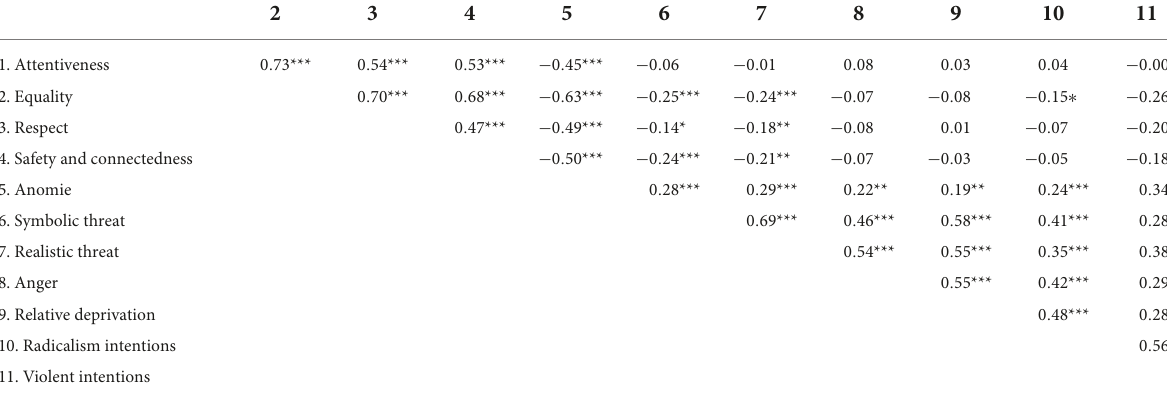
TABLE 2 Correlations between main study variables.